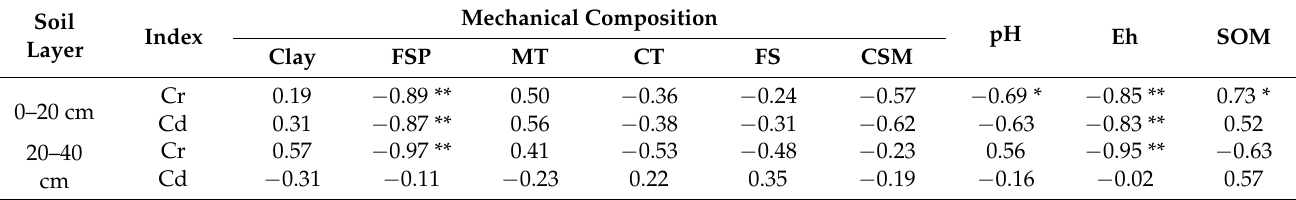
Table 6. Correlation analysis between soil heavy metal activity and soil physical and chemical properties. Soil